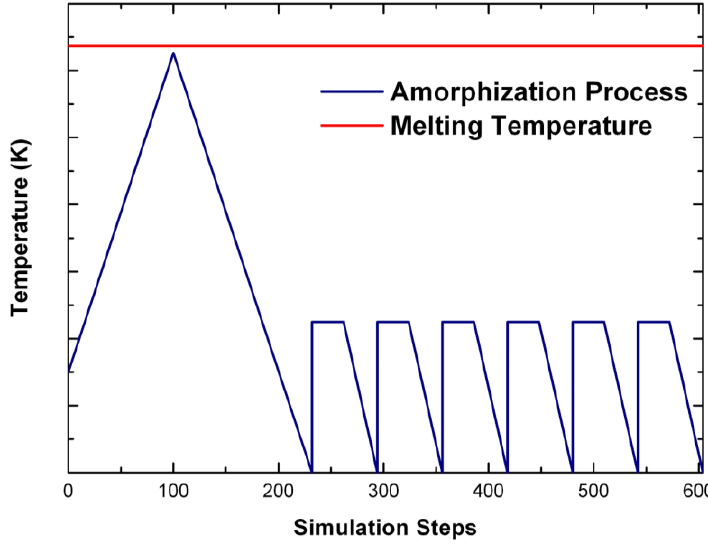
Figure 1. Schematic representation of the original undermelt-quench approach. The first process (triangular) is the randomizing part; the rest are the stress-relieving cycles. At the end a geometry optimization is carried out. The temperatures considered are specific to each material. For variants of this process see